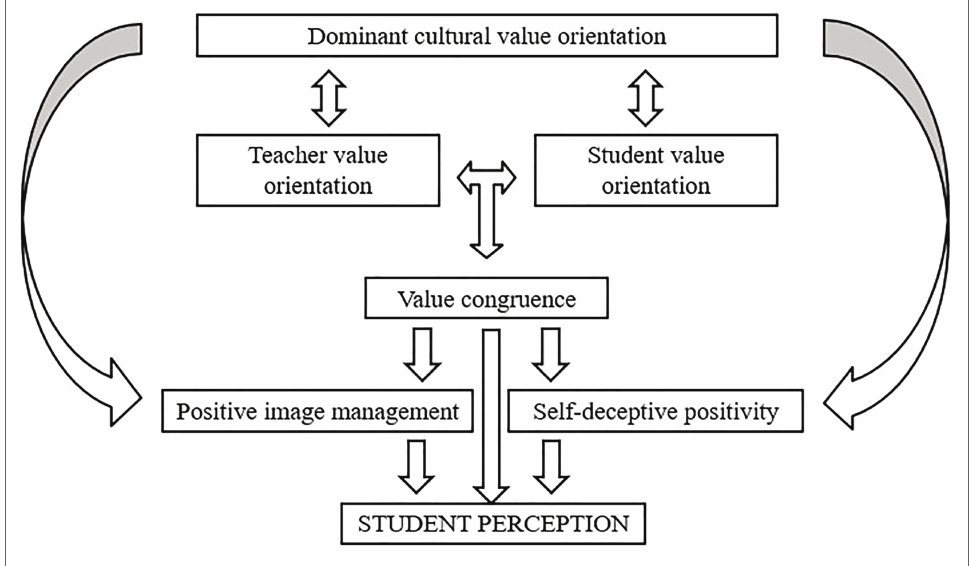
FIGURE 4 | The Proposed Conceptual